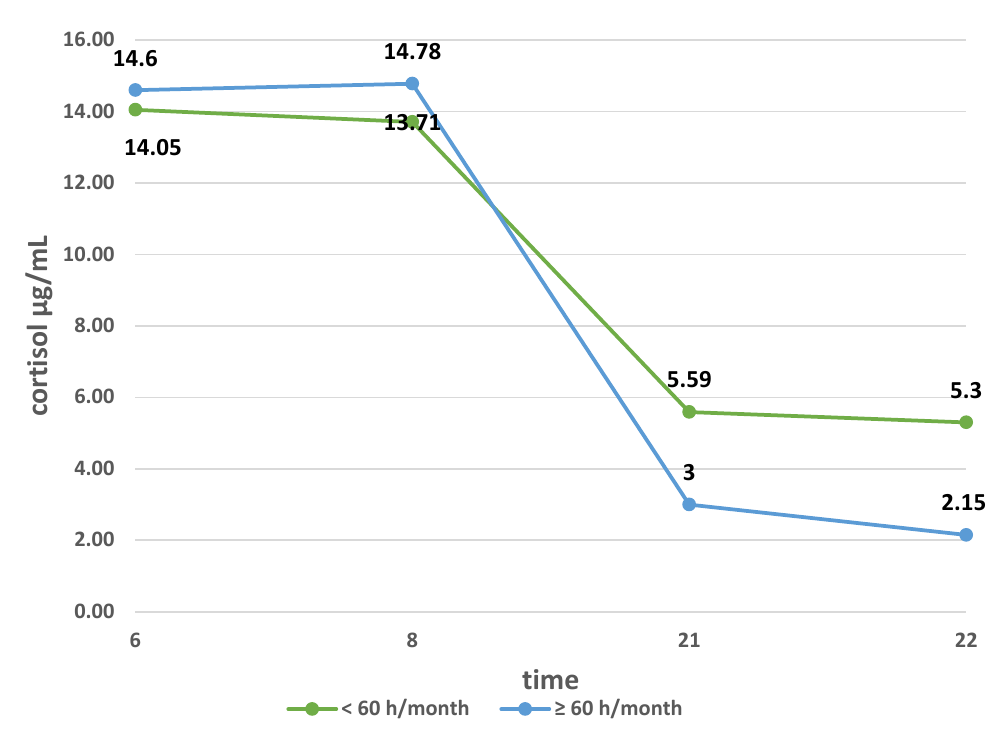
Figure 5. Diurnal cortisol profile depending on the frequency of flying.